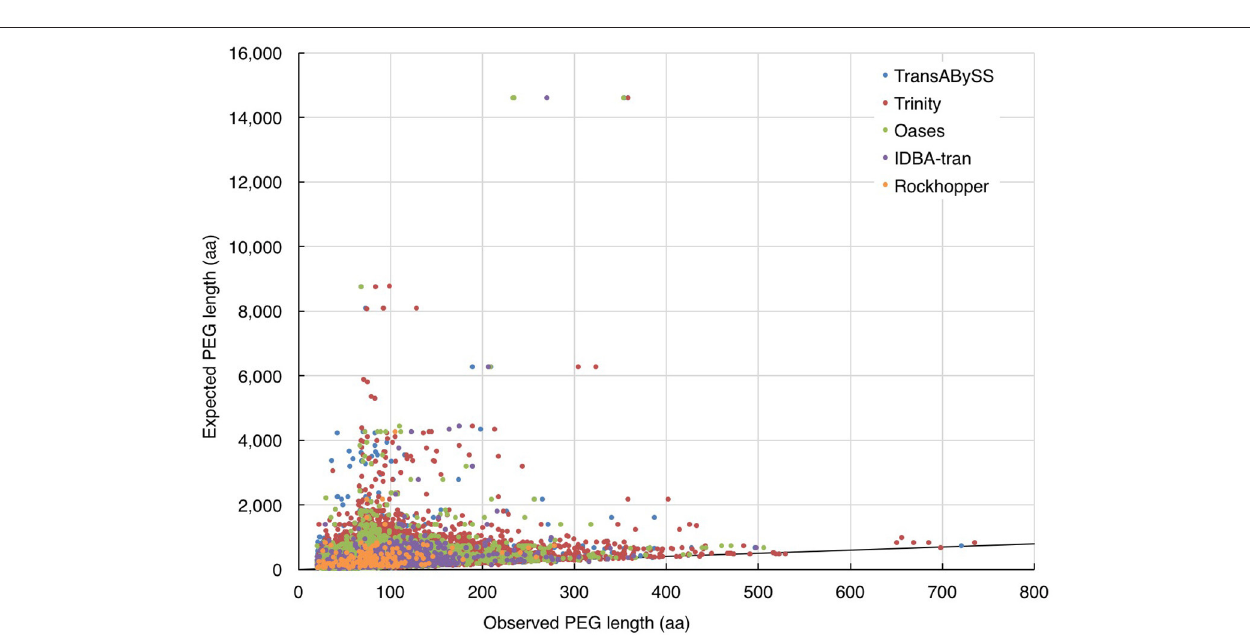
FIGURE 6 | Evaluation of the length of assembled PEGs. The length of quality-filtered PEGs (observed) was compared to the maximum length of qualified BLASTp best hits of the query transcript sequence (expected). The solid line denotes the full-length annotations. of the f-Tag 0.90 clusters represent genuinely different variants of the metabolic gene. Of these 863 consensus protein IDs, 89 were related to conserved single-copy genes and 29 were related to hypothetical proteins (see Supplementary Text for